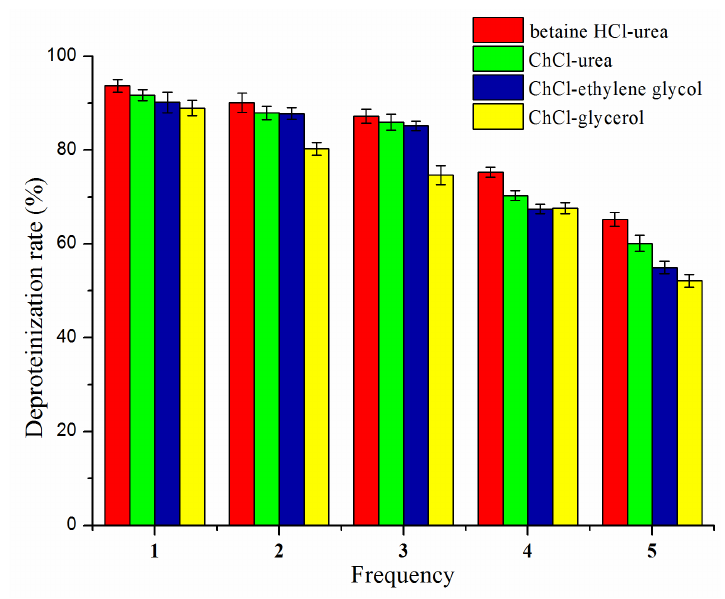
Figure 5. Reusability of the DESs.